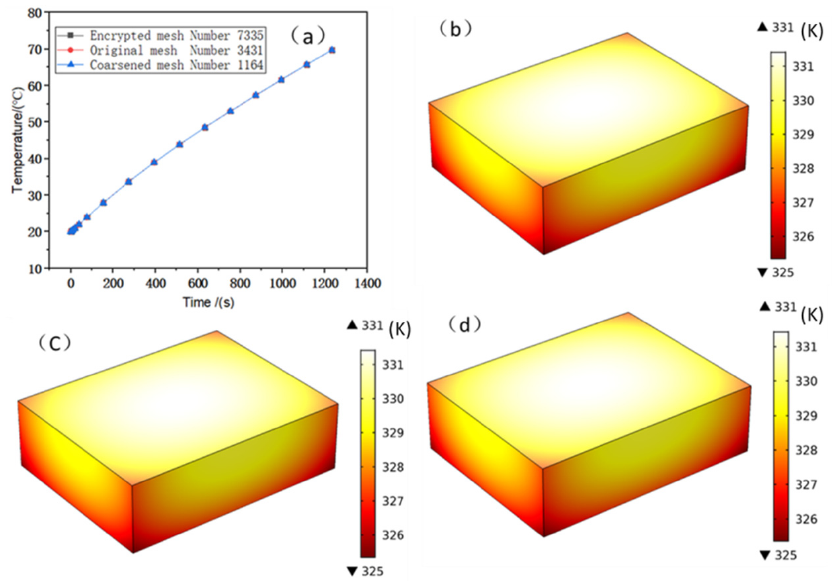
Figure 11. ( a ) Temperature curves of the battery body under different mesh densities; ( b – d ) temperature contours of the battery under encrypted, original, and coarsened meshes, respectively.